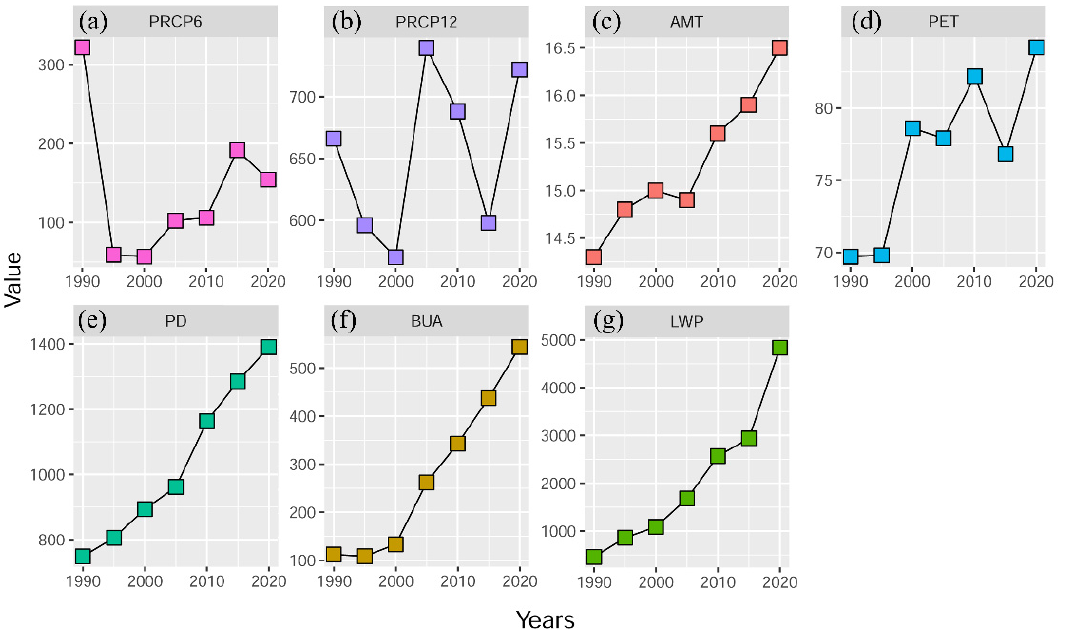
Figure 5. Potential driving factors influencing changes in surface water from 1990 to 2020 in Zhengzhou, China. ( a ) Average monthly precipitation in the 6 months prior to satellite image capture (PRCP6, mm), ( b ) average monthly precipitation in the 12 months prior to satellite image capture (PRCP12, mm), ( c ) annual mean temperature (AMT, °C), ( d ) potential evapotranspiration (PET, mm), ( e ) population density (PD, human population per km 2 ), ( f ) built-up area (BUA, km 2 ), and ( g ) length of water pipeline (LWP, km). Table 4. Selection of the most predictive climatic and anthropogenic variables for the total surface area of each waterbody type. Corrected Akaike Information Criterion (AICc) values are shown in the table and were used to select the predictor variables for the linear regression models shown in Table 5. The variables of AICc from low to high are indicated by 1 (cid:13) 2 (cid:13) 3 (cid:13)